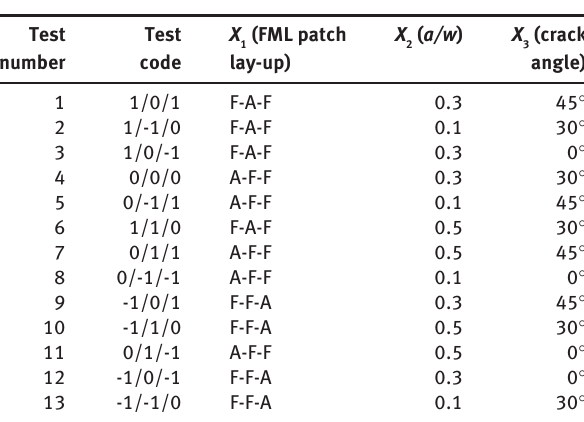
Table 5 Description of the tested specimens’